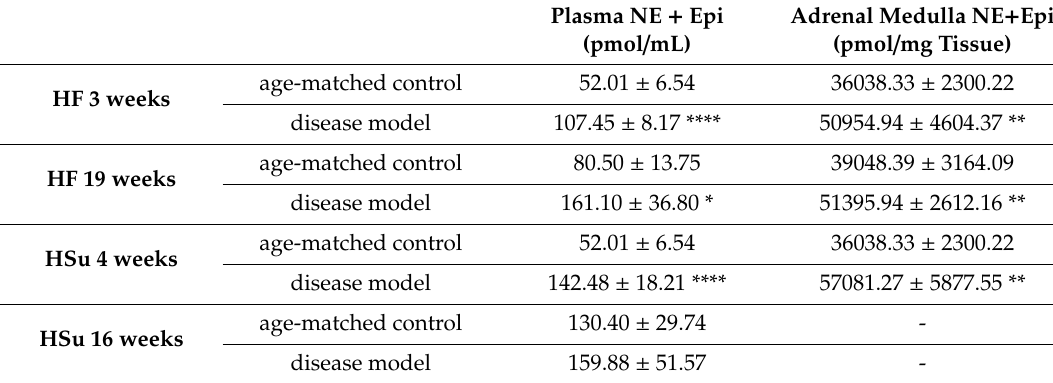
Table 2. Catecholamine (epinephrine and norepinephrine) levels in plasma and in adrenal medulla in animal models of obesity and type 2